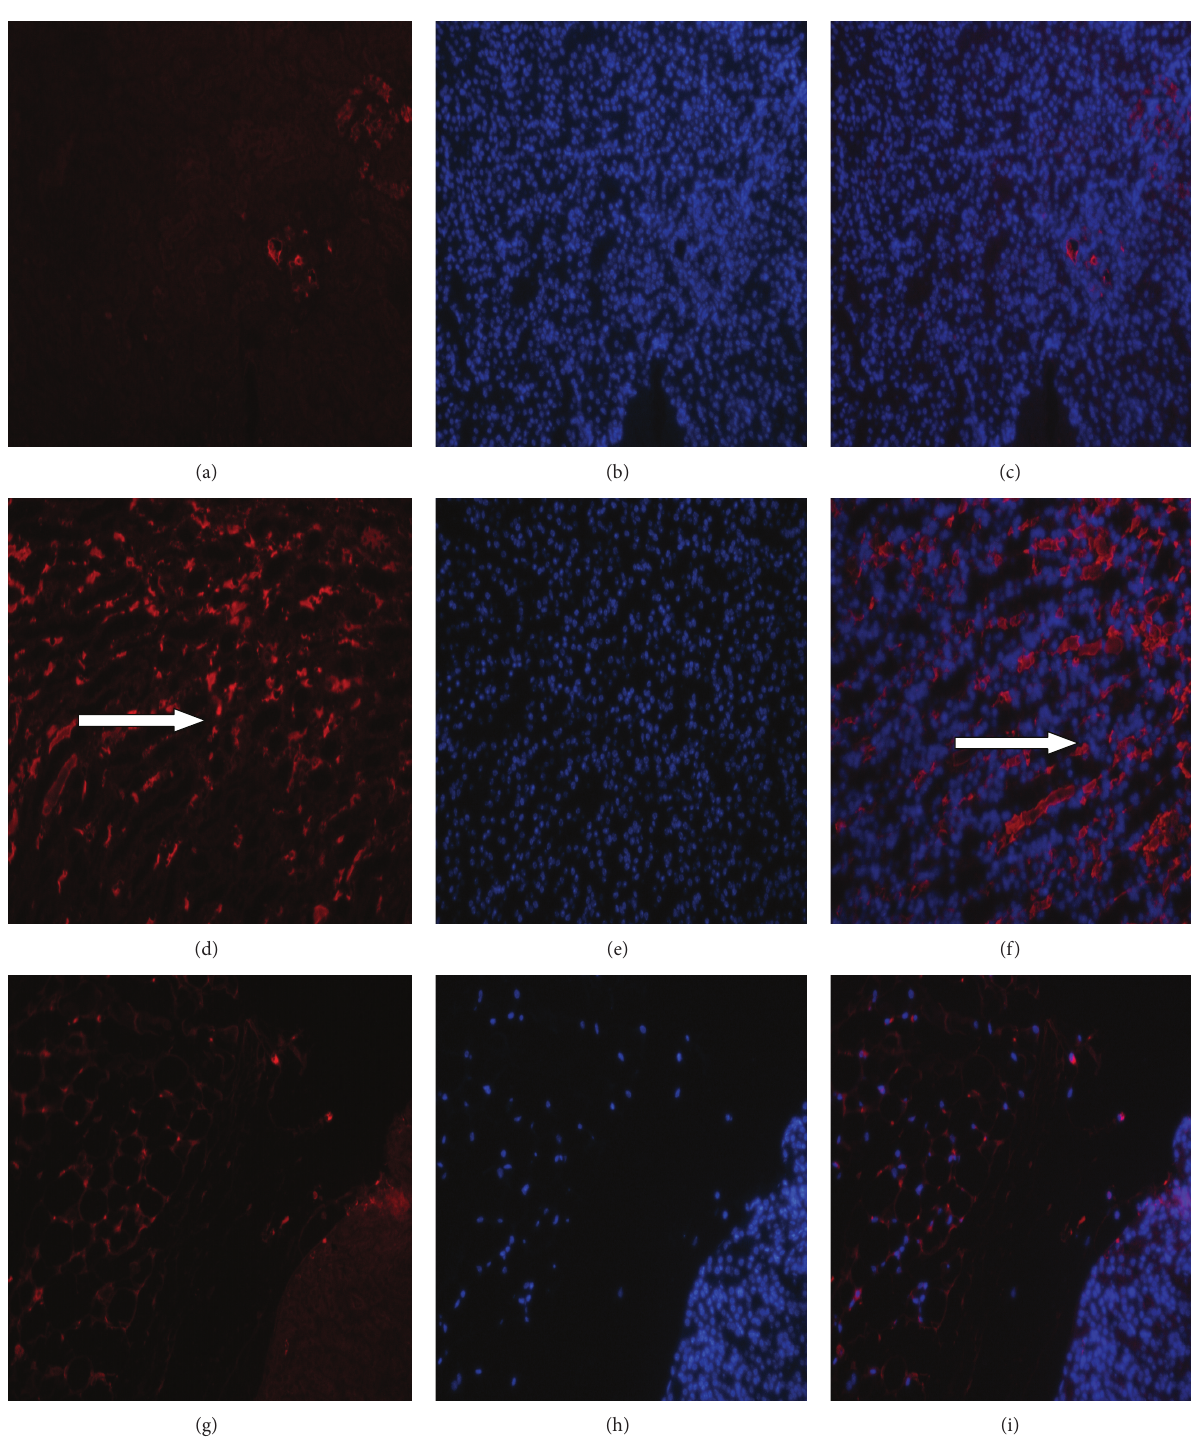
Figure 4: The deposition of immune complexes in the kidneys as observed by fluorescence microscopy. (a–c) C57BL/6 mouse normal control group. (d–f) B6.Fas mouse model group. (g–i) B6.Fas mouse high-dose group. ((a), (d), and (g)) PE staining. ((b), (e), and (h)) DAPI staining. ((c), (f), and (i)) Merged images. The arrows show red fluorescence immune